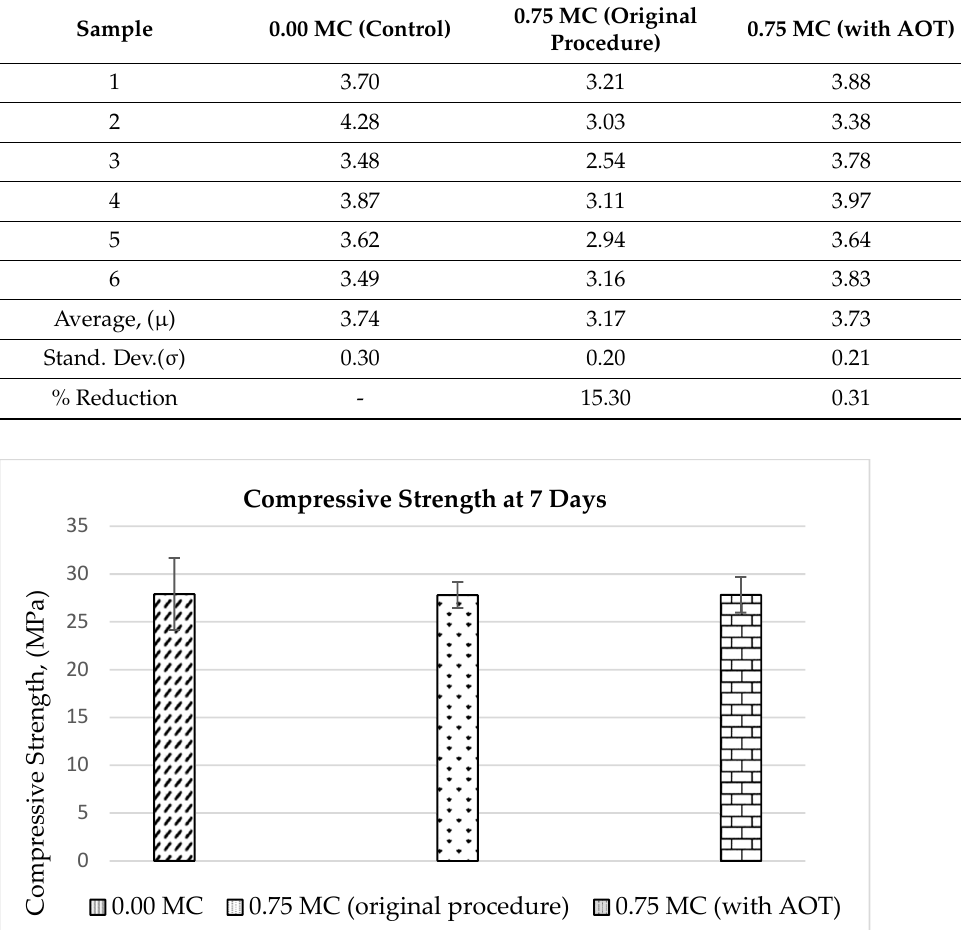
Figure 4. Compressive strength versus microcapsule concentration at 7 curing days (Error bars = standard deviation).